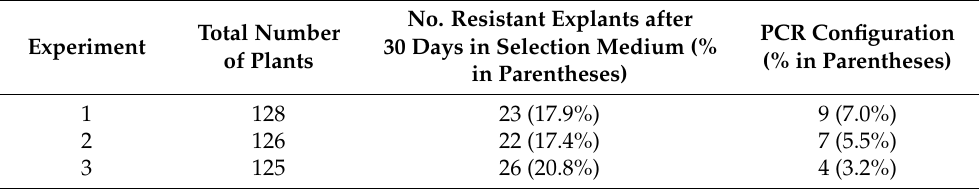
Table 3. Summary of the GUS transformation efficiency statistics. Total of 379 explants tested: 5.2% of those were confirmed by PCR at explant level after 30